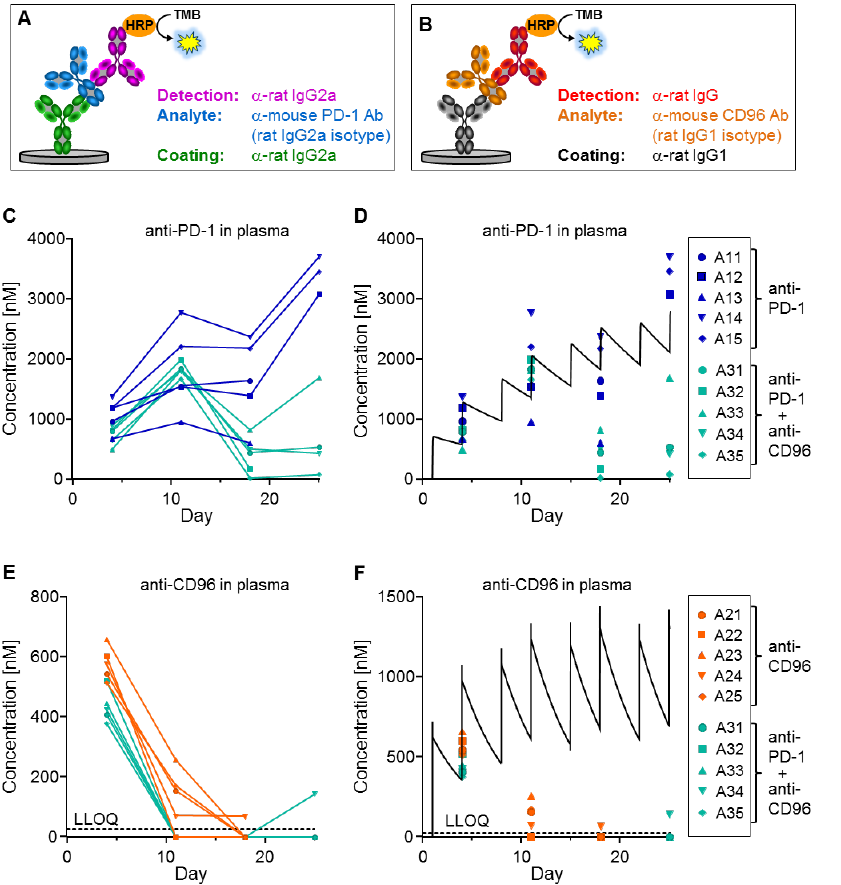
Figure 4. Exposure measurement of tumor therapy study. ( A , B ) ELISA setup against anti-PD-1 and anti-CD96. ( C , E ) Plasma concentrations of anti-PD-1 and anti-CD96 were determined for 5 animals per group and plotted against time. Samples below LLOQ are plotted on the x -axis. ( D , F ) Simulated concentration–time curves (black lines, see Figure 2C) are compared with the measured data for anti-PD-1 and anti-CD96, respectively. Treatment groups are shown on the right. Plasma samples for animals 11, 13, 21–25 and 32 at day 25 are missing because these animals were sacrificed due to high tumor load.